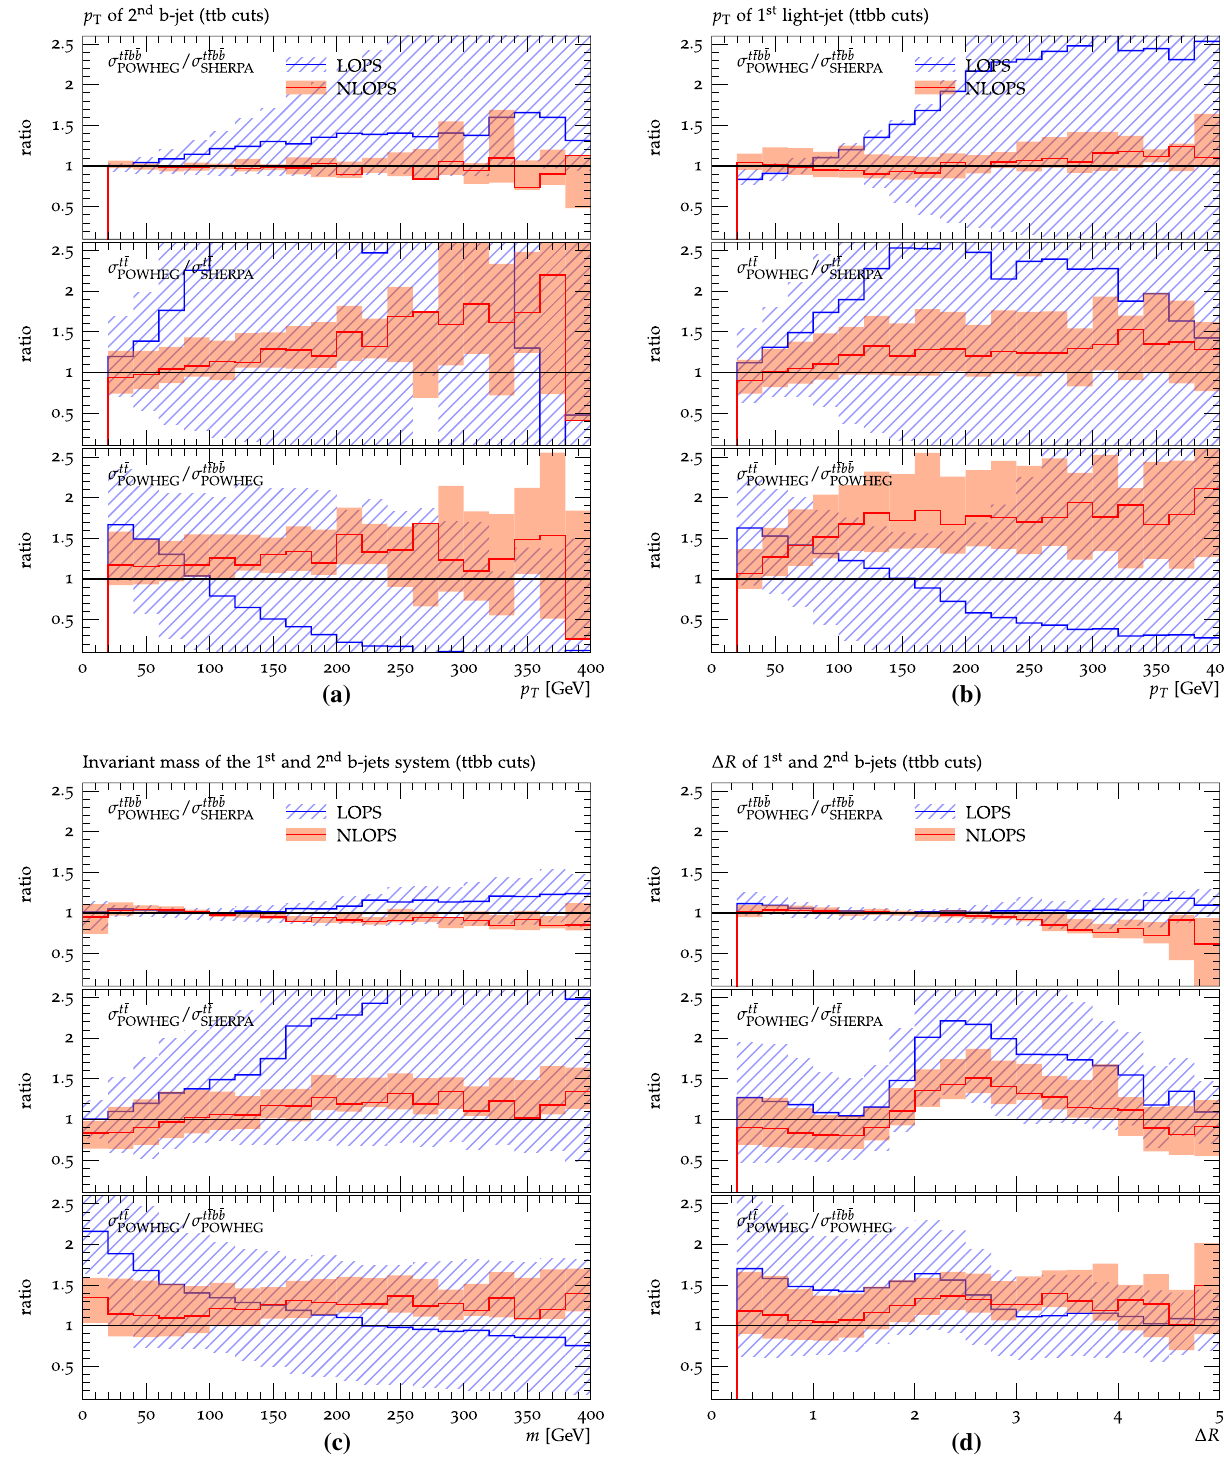
Fig. 12 Distributions in the p T of the second b -jet ( a ) in the p T of the first light jet ( b ), and in the invariant mass ( c ) and the Δ R separation ( d ) of the first two b -jets with ttbb cuts throughout. Predictions and uncertainties as in Fig.